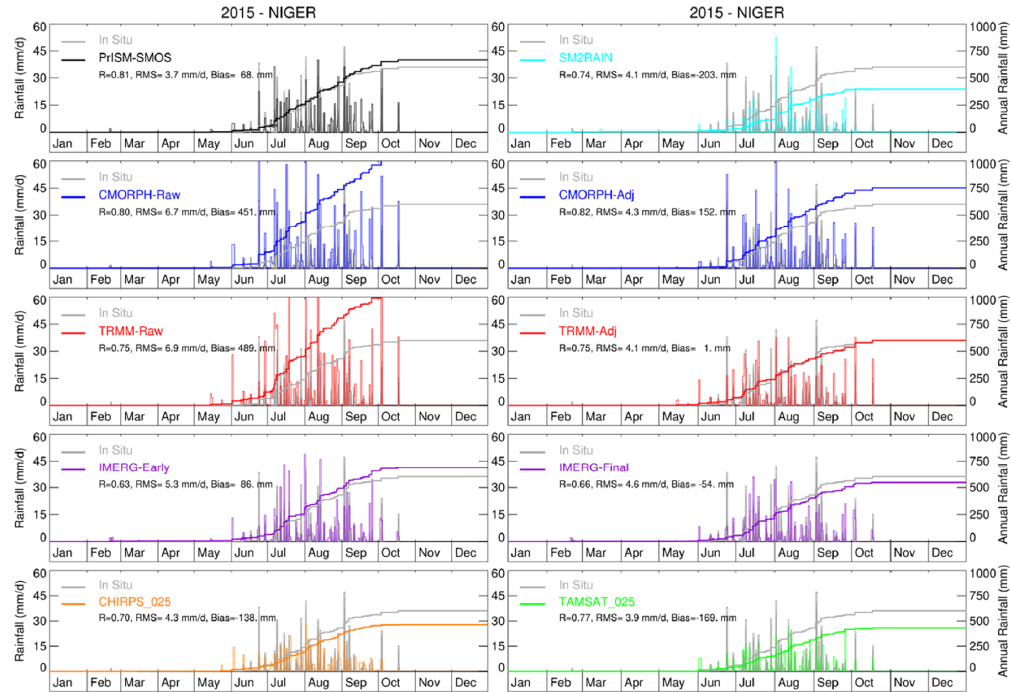
Figure A1. Example of comparison between in situ precipitation measurements (Niger 0.25° site, 2015, in grey) and the ten precipitation products (PrISM, SM2RAIN, CMORPH (Raw and Adj), TRMM (Raw and Adj), IMERG (Early and Final), CHIRPS-025 and TAMSAT-025). Statistical scores are reported in Table 3.